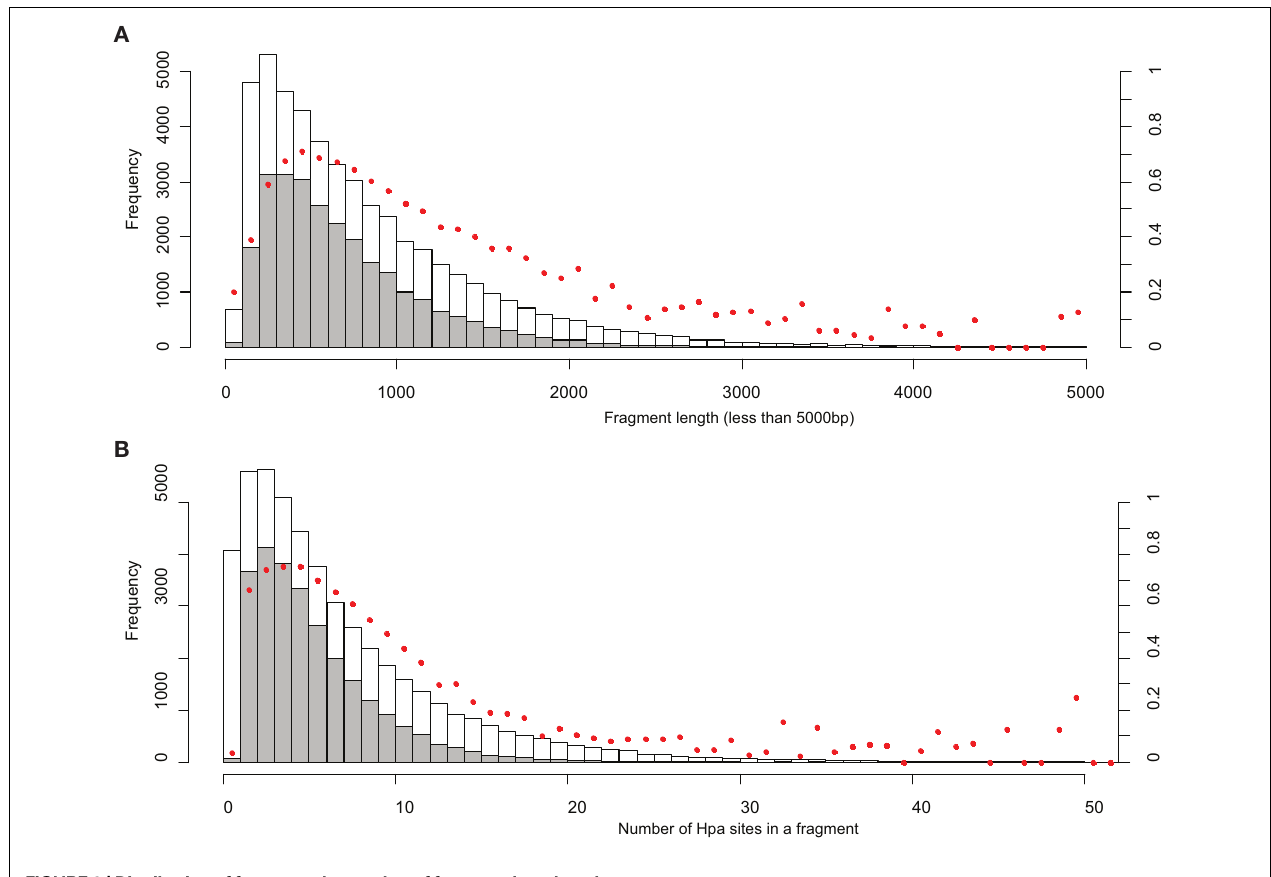
bars) were compared with in silico prediction (100% methylated – white bars). The percentage of observed positives is depicted as red dots for each increment. In (A) the length of fragments was separated by 100 bp increments up to 5000 bp. In both plots, the red dot values drop off with increasing number of HpaII sites or fragment